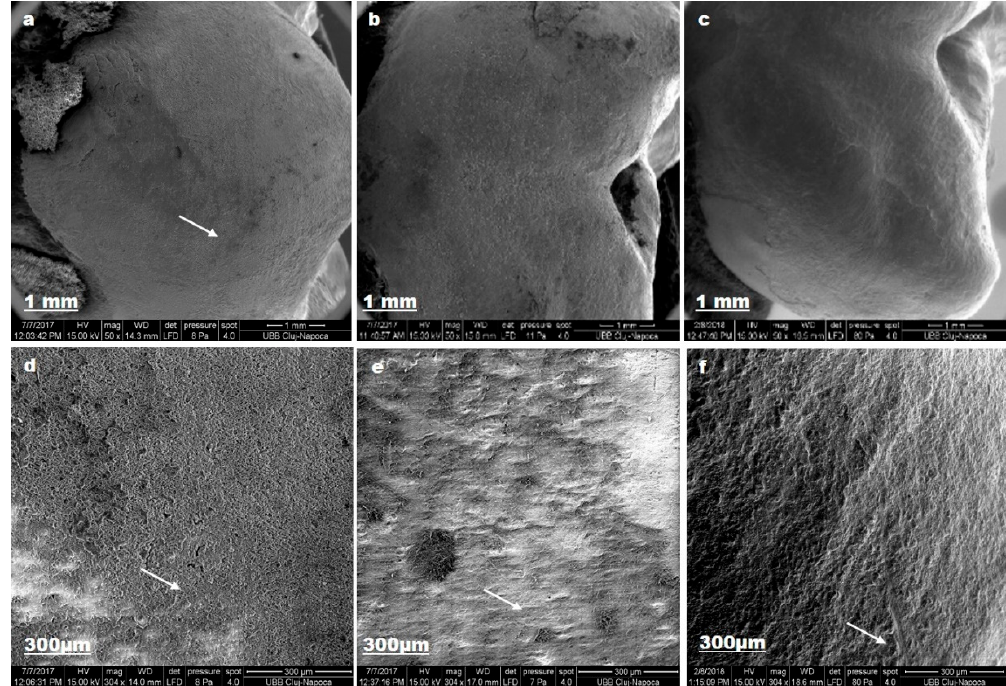
Figure 10. Experim_tp SEM images for sound enamel after T1 ( a , d ), demineralized enamel surface T2 ( b , e ), enamel surface after T3 ( c , f ). ( b , e ), enamel surface after T3 ( c , f